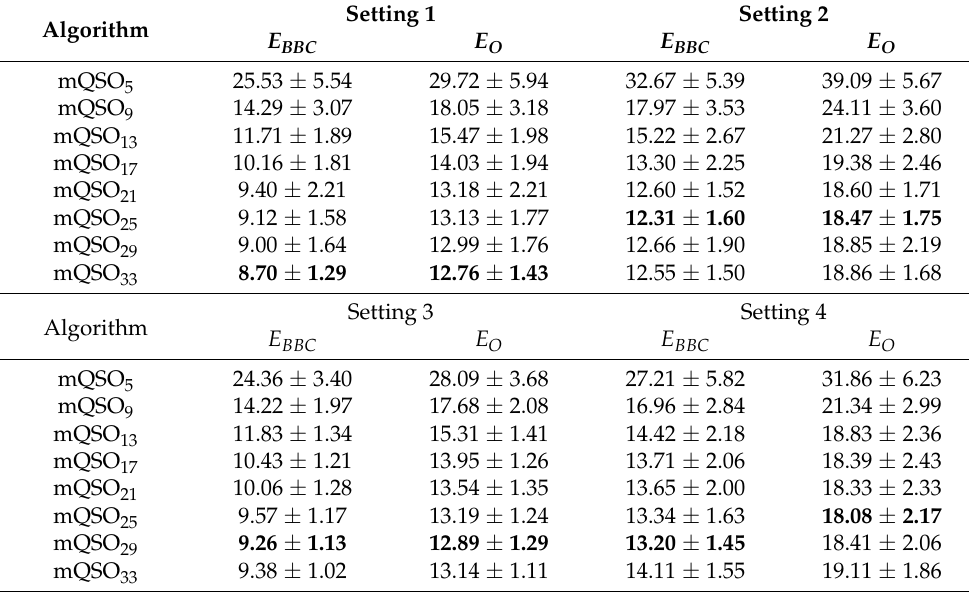
Table 3. Comparison of mQSO with different population